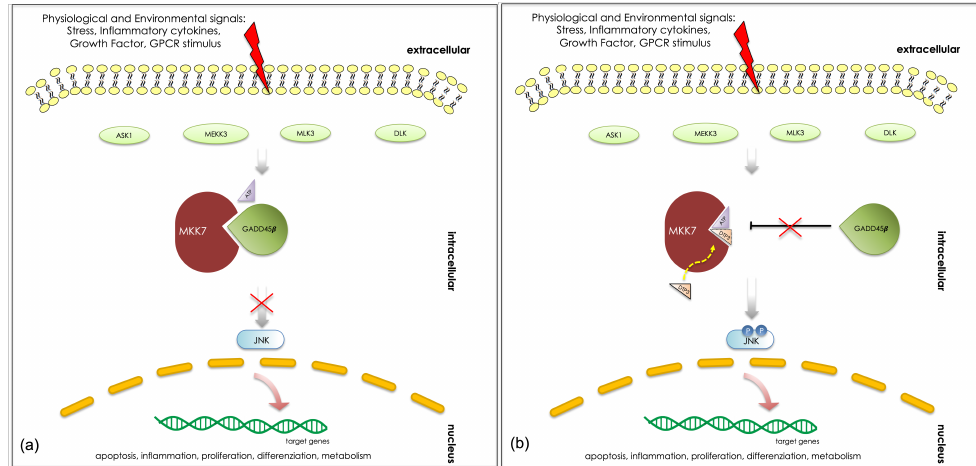
Figure 1. The GADD45 β -regulated MKK7 signaling cascade in absence ( a ) and in presence ( b ) of the DTP3 peptide inhibitor. DTP3 interaction with MKK7 restores its kinase activity and the JNK- mediated apoptotic signal by preventing the GADD45 β